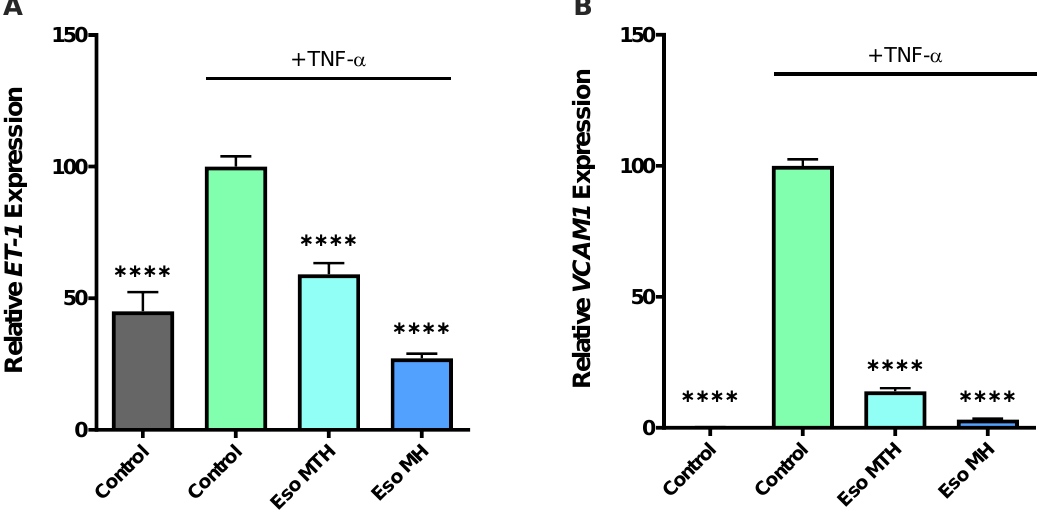
Figure 2. Esomeprazole reduced expression of markers of endothelial dysfunction in response to tumour necrosis factor (TNF)- α, compared with vehicle control in primary HUVECs. Expression of two markers of endothelial dysfunction, endothelin-1 ( ET-1 ) ( A ), and vascular cell adhesion molecule-1 ( VCAM1 ) ( B ) was increased in HUVECs treated with TNF- α (10 ng/mL) after 24 h (control + TNF- α , green); HUVECs not treated with TNF- α (control, grey) have significantly lower expression of markers assessed. Both esomeprazole magnesium trihydrate (Eso MTH) and esomeprazole magnesium hydrate (Eso MH) at 100 μmol/L abolished the increase in both ET-1 ( A ), and VCAM1 ( B ) mRNA expression in response to TNF- α. Data expressed as mean ± SEM. **** p < 0.0001 ( n = 3).